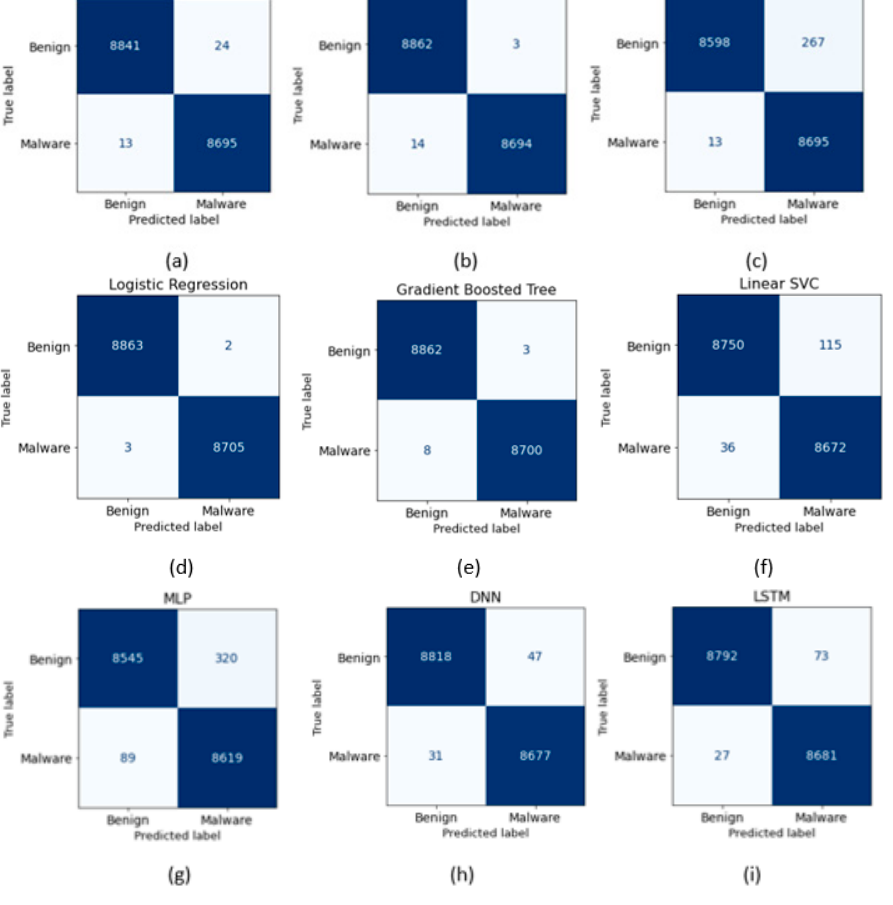
Figure 11. Confusion Matrix of ( a ) Decision Tree; ( b ) Random Forest; ( c ) Naive Bayes; ( d ) Logistic Regression; ( e ) Gradient Boosted Tree; ( f ) Linear SVC; ( g ) MLP; ( h ) DNN; ( i ) LSTM.